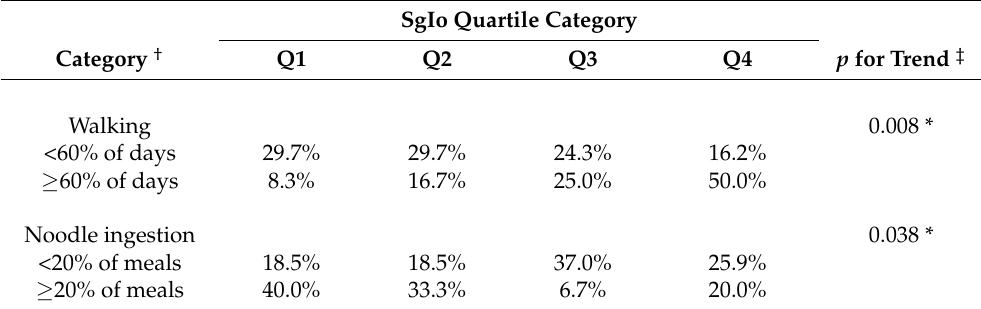
Table 7. Proportions of the SgIo quartile category stratified with the walking ( ≥ 8000 steps) day or frequency of noodle ingestion